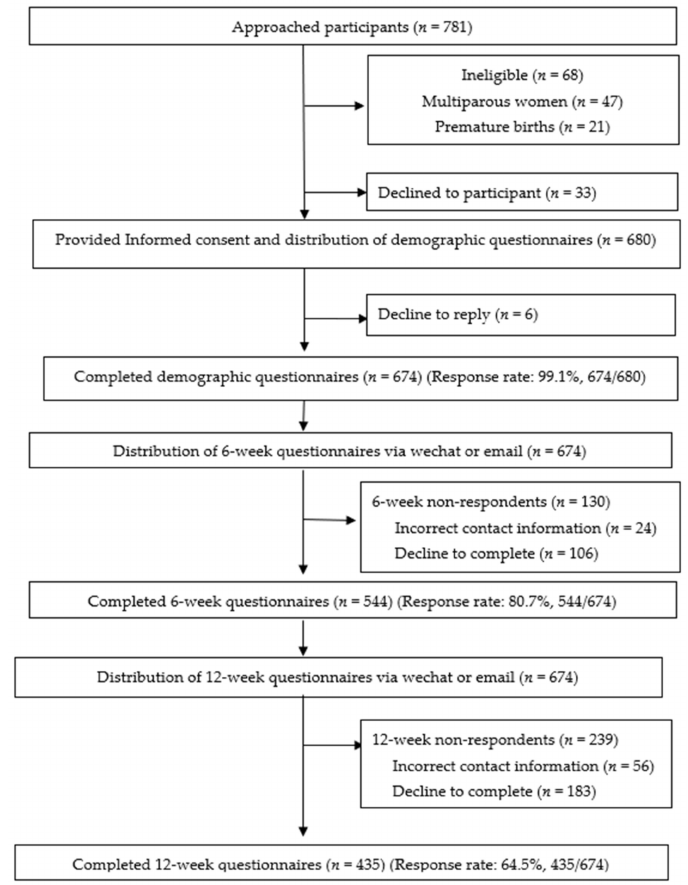
Figure 1. Recruitment and participant flow in this